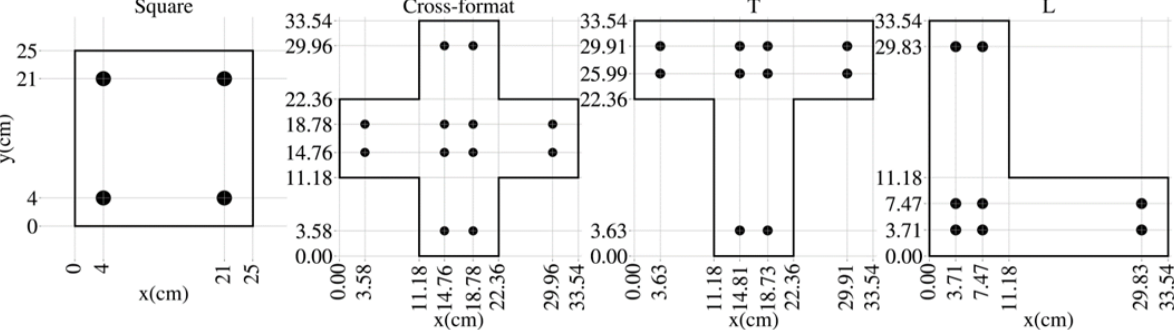
Figure 3. Geometry of analyzed